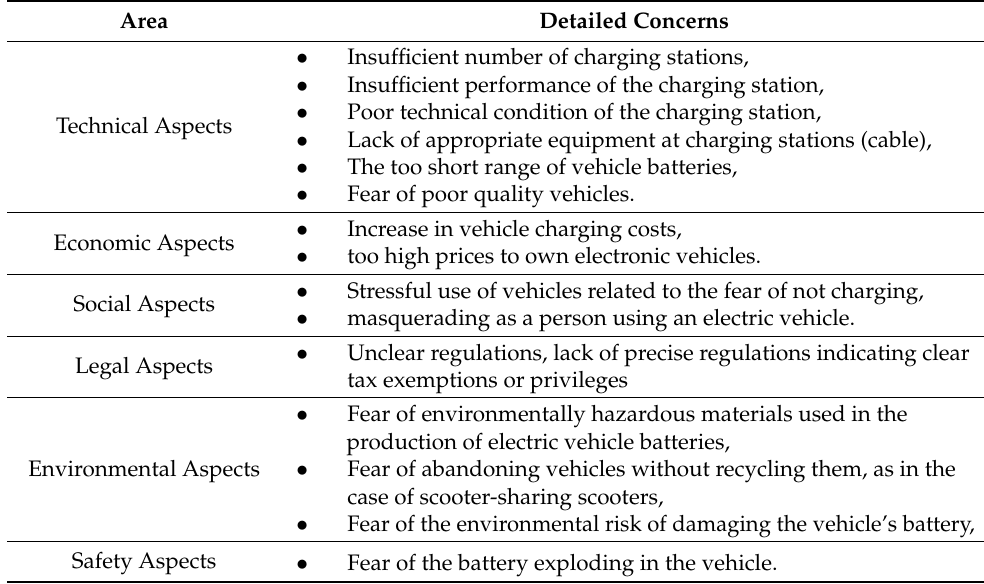
Table 3. Diagnosed main concerns in the field of electric